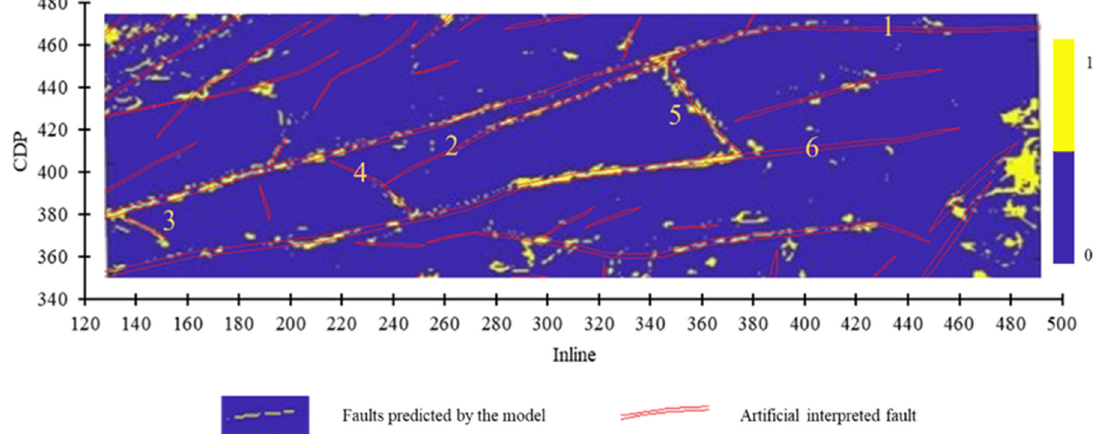
Figure 14. The prediction result of Faults 1–6 by Region A as training set.